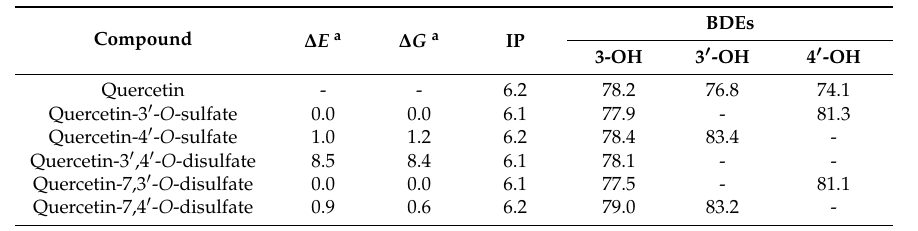
Table 4. Relative electronic energies ( ∆ E , kcal · mol − 1 ), relative Gibbs energies ( ∆ G , kcal · mol − 1 ), ionization potential (IP, eV) and O-H bond dissociation enthalpies (BDEs, kcal · mol − 1 ) of quercetin